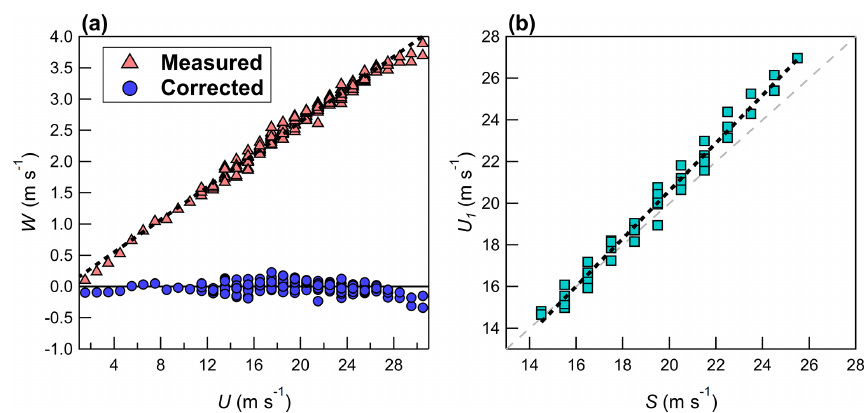
Figure 3. (a) The measured vertical velocity W (red), plotted as a function of the measured longitudinal velocity U and the corrected vertical velocity W c (blue) after application of Eq. (1); (b) the measured U 1 as a function of vehicle speed S (after application of Eq. 1). Measurements are binned using a bin size of 1ms − 1 . Data shown are for both 20 and 22 August. Black dashed lines give a least square fit: (a) W = 0 . 03 + 0 . 13 U ( R 2 = 0.99) and (b) U 1 = − 2 . 34 + 1 . 147 S ( R 2 = 0.98).